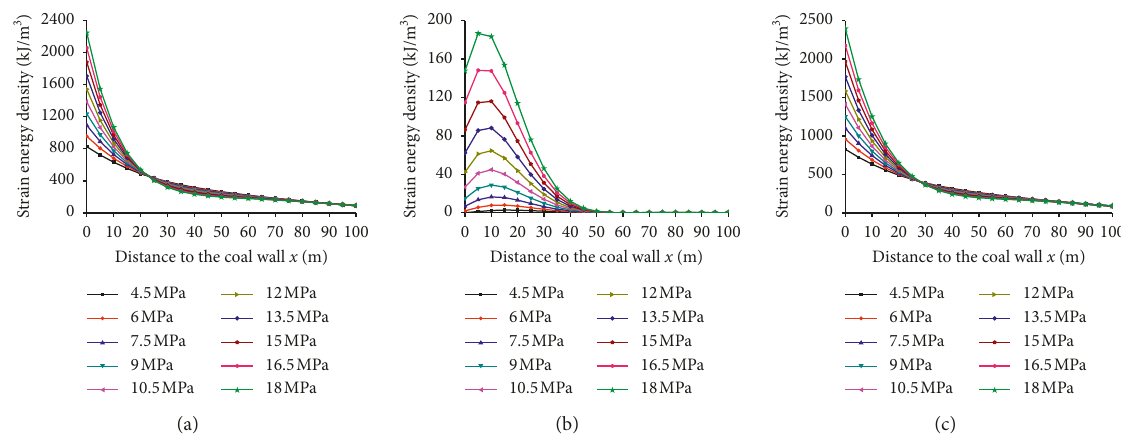
Figure 10: Strain energy densities before the initial breakage event. (a) Coal mass. (b) Roof rock mass. (c) Overall working